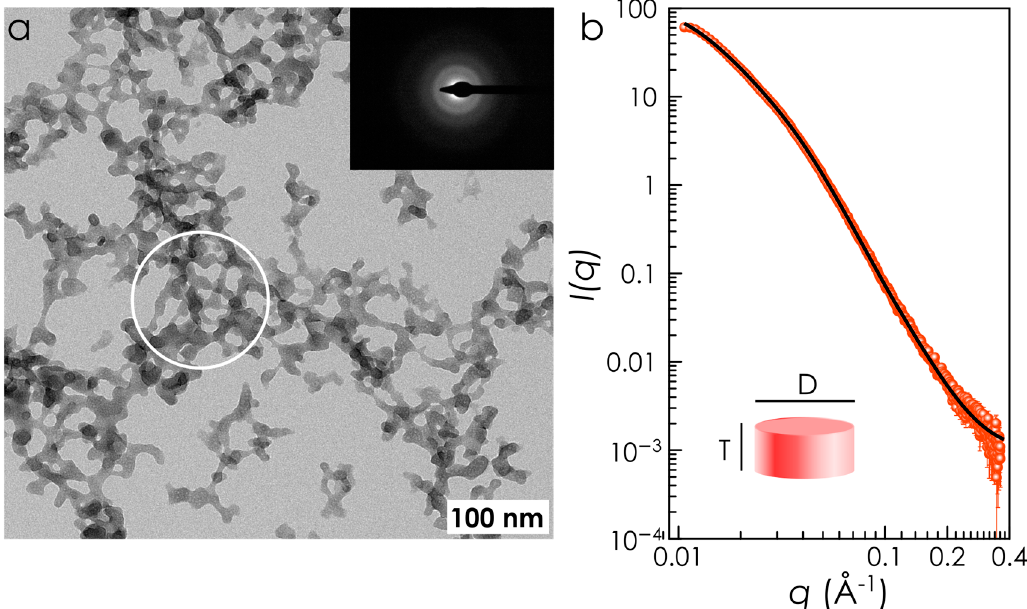
Figure 1. Morphological characterization of U-ACP nanocomposites. ( a ) TEM micrograph of U-ACP nanoparticles. The amorphous nature of the particles is confirmed by the lack of diffraction spots in the selected-area electron diffraction (SAED) pattern (inset). SAED pattern was collected on the particles under the white circle. Mean particle diameter of 13.8 nm and dispersion (standard deviation) of 4.2 nm were obtained after measuring 100 nanoparticles. ( b ) SAXS data (log-log scale, symbols) and best fitting (line) obtained with analytical form factors of a finite disk-shaped model (inset). The analysis provided number-based mean diameter, <D> N = 13.5 (3) nm, and thickness, <T> N = 3.46 (6) nm.